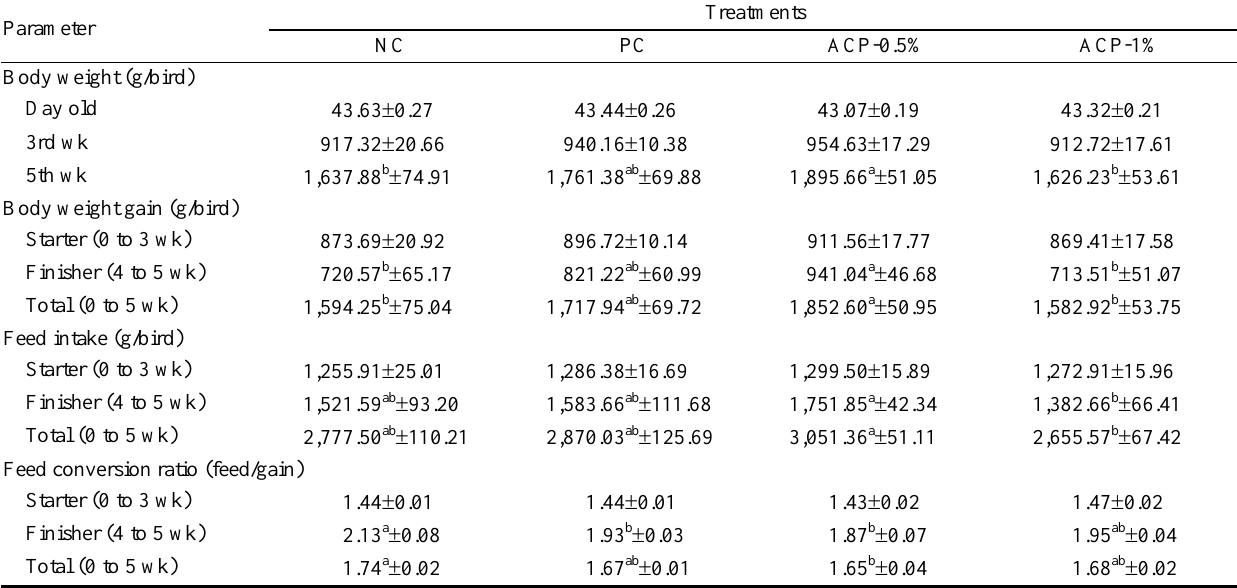
Table 3. Effect of Alisma canaliculatum with probiotics on growth performance of broilers